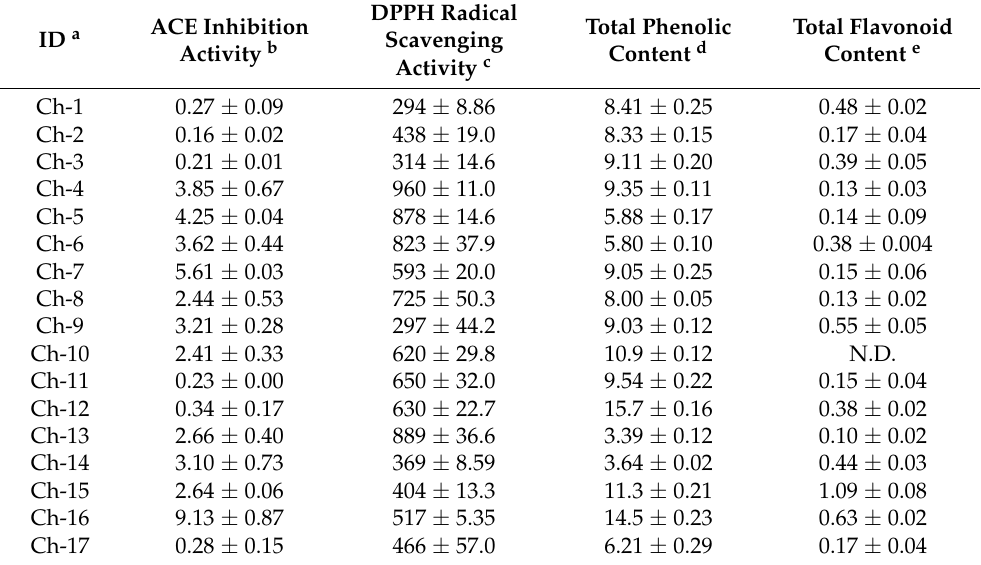
Table 2. ACE inhibition activity, DPPH radical scavenging activity, and total phenolic and flavonoid content of leaf